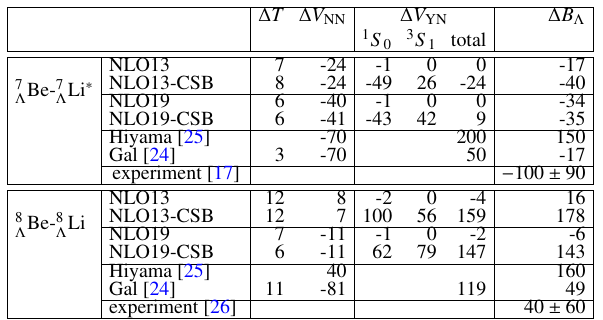
Table 2: Contributions to CSB in the A = 7 and 8 isospin multiplets, based on the YN potentials NLO13(500) and NLO19(500) (including 3N and SRG-induced YNN forces). The results are for the original potentials (i.e. without CSB force) and for the scenario CSB1 [16]. The estimated